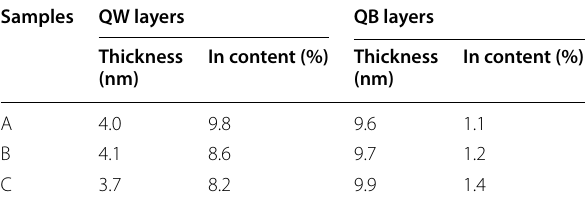
Table 1 Structural parameters of MQWs of samples A, B and C determined by HRXRD measurements